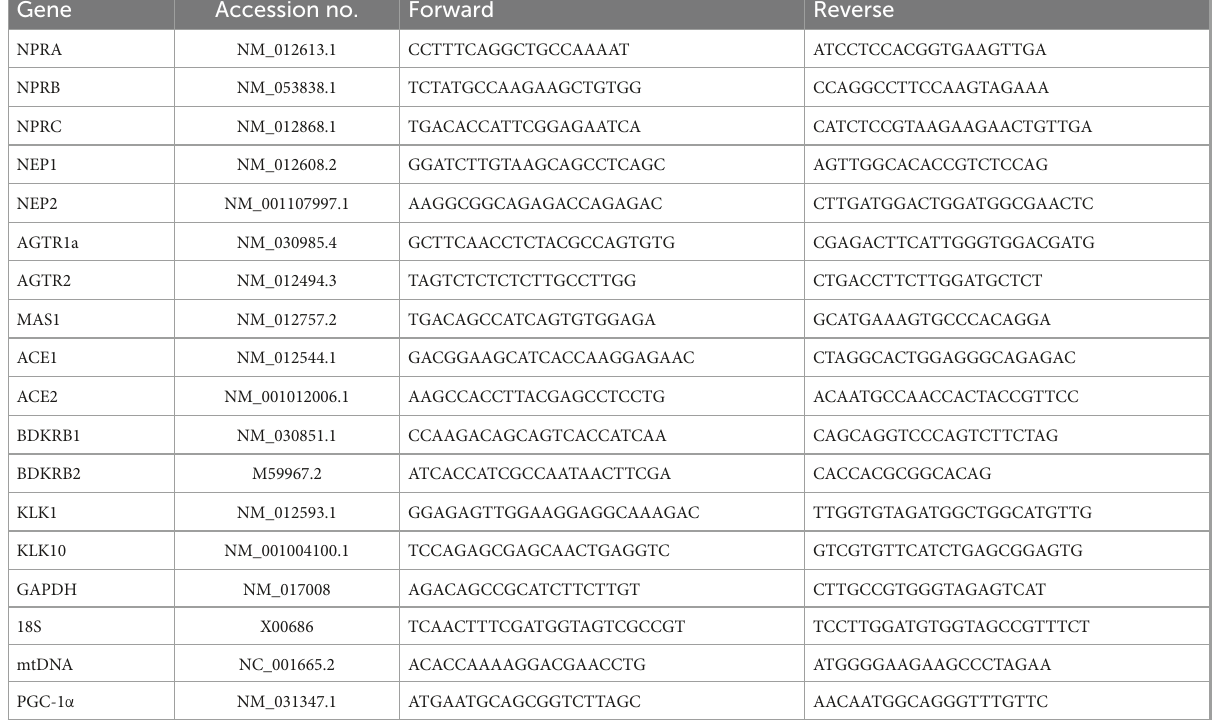
TABLE 1 List of qPCR primers